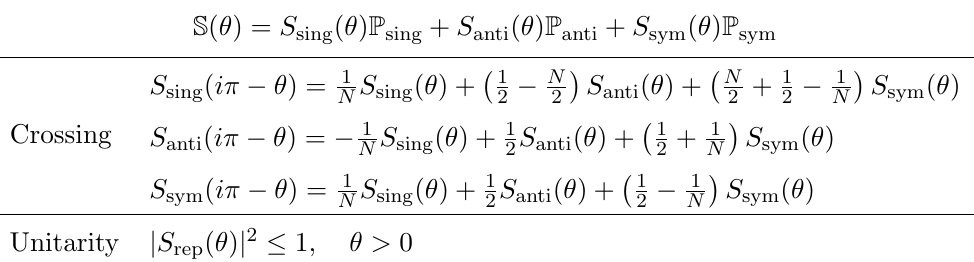
Table 2 . Crossing and unitarity for the S-matrix in the representation decomposition (2.3). Uni- tarity is simple since the various representations diagonalize the scattering evolution while